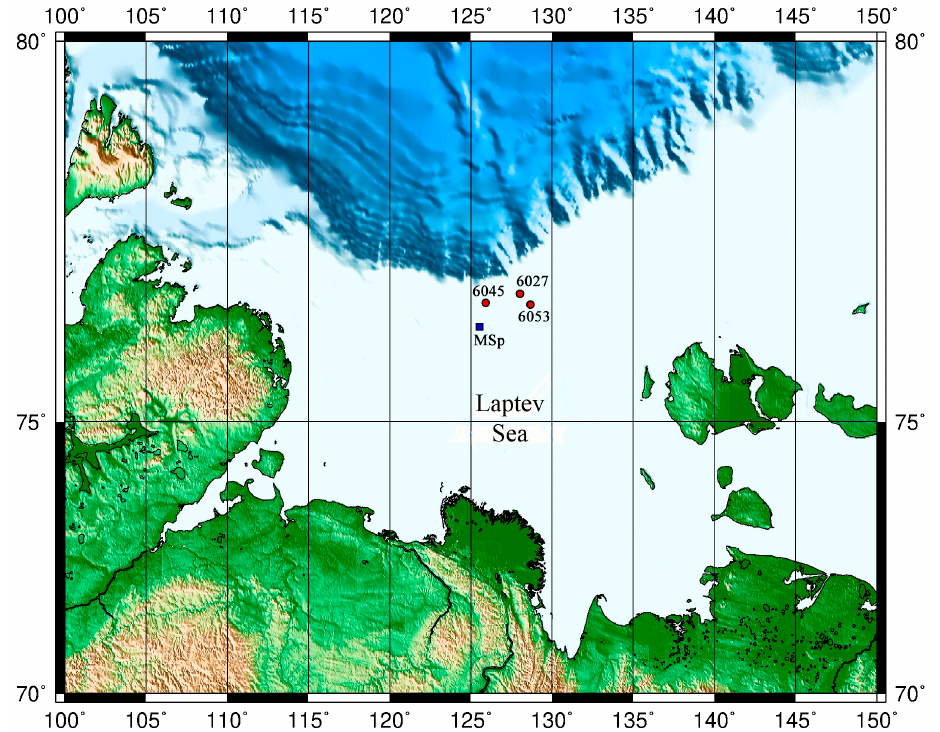
Figure 1. Schematic map of the studied area (Laptev Sea). AMK 6027, 6045, and 6053 are the stations in the shelf edge area. MSp is the methane seep polygon [18].